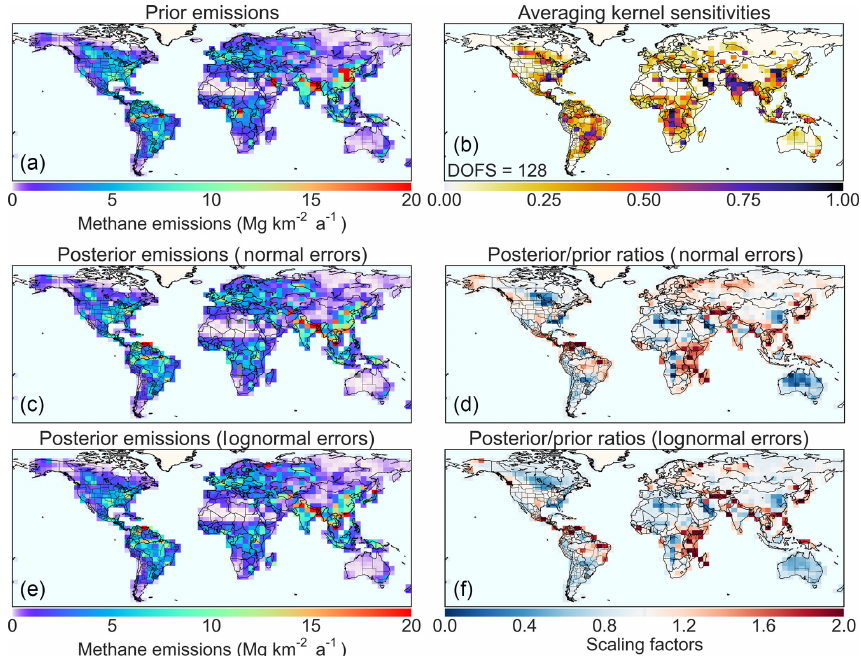
Figure 4. Optimization of the global distribution of mean 2010–2015 methane emissions using GOSAT observations. Prior emissions are in (a) (see breakdown in Fig. 2). Panel (b) shows averaging kernel sensitivities for the base inversion (diagonal elements of the averaging kernel matrix), with the degrees of freedom for signal (DOFS; trace of the averaging kernel matrix) in the legend. Panels (c, d) show the posterior emissions from the base inversion and the associated ratios between posterior and prior emissions. Grey grid cells (for example in North Africa and Australia) indicate small negative posterior emissions. Panels (e, f) show the same but for the inversion assuming lognormal prior errors, which does not allow for negative posterior